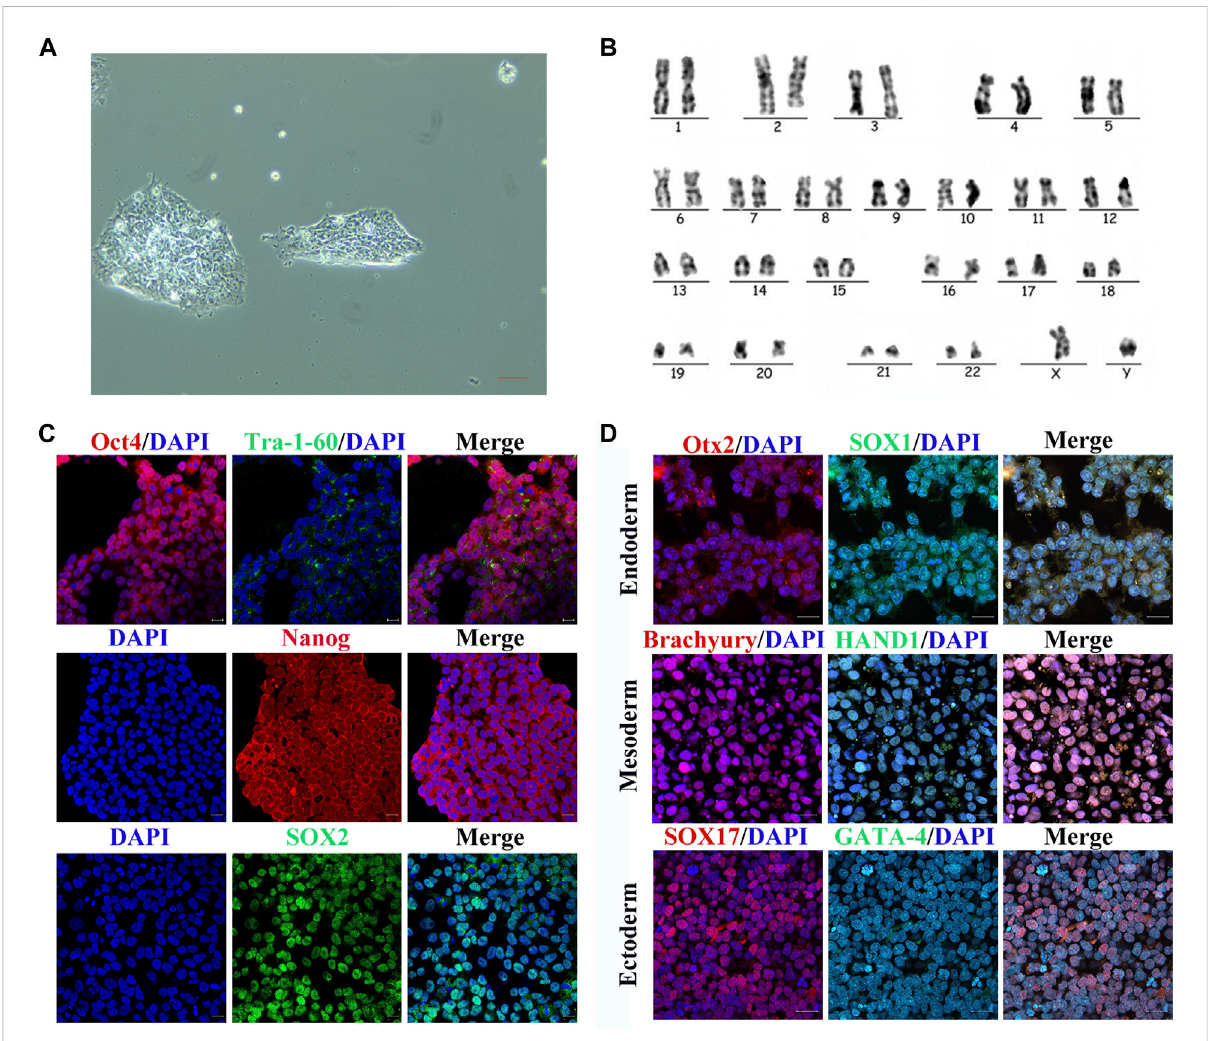
Characterization of hiPSCs. (A) Normal monoclonal morphology of hiPSCs in serum-free medium assessed by optical microscopy. Scale bar represents 20 μ m. (B) Normal chromosomes revealed by karyotype analysis of hiPSCs. (C) Immuno fl uorescence images of pluripotency markers (Oct4, Tra-1-60, Nanog, and SOX2) in hiPSCs. Scale bar represents 50 μ m. (D) Immuno fl uorescence images of germ layer markers after hiPSC differentiation. Scale bar represents 50 μ